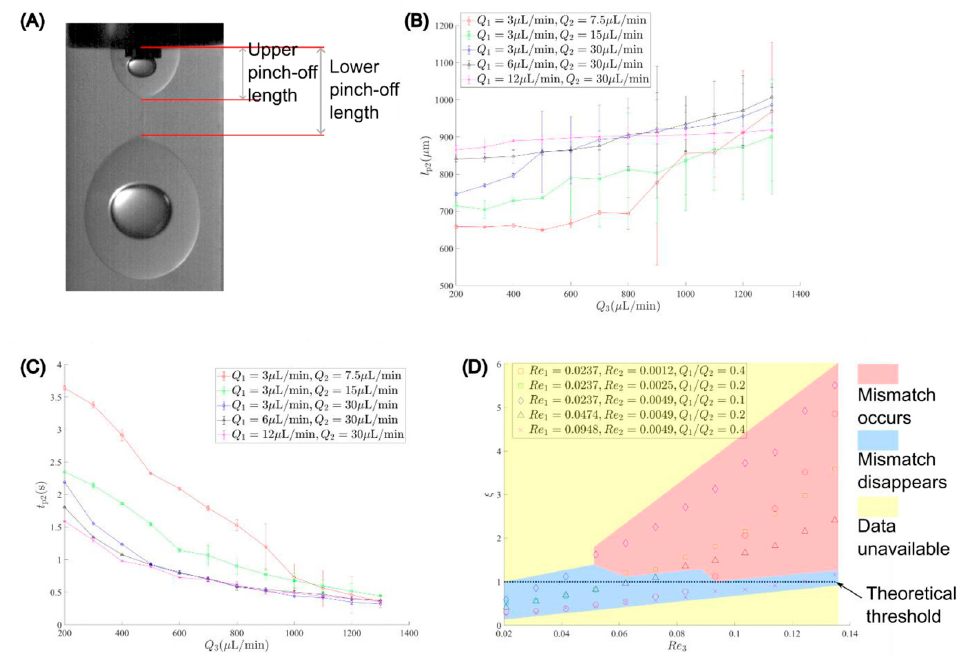
Figure 7. Pinch-off parameters: ( A ) pinch-off length measurement; ( B ) pinch-off length versus the continuous phase flow rate; ( C ) pinch-off time versus the continuous phase flow rate; ( D ) match ratio versus the continuous phase Reynolds